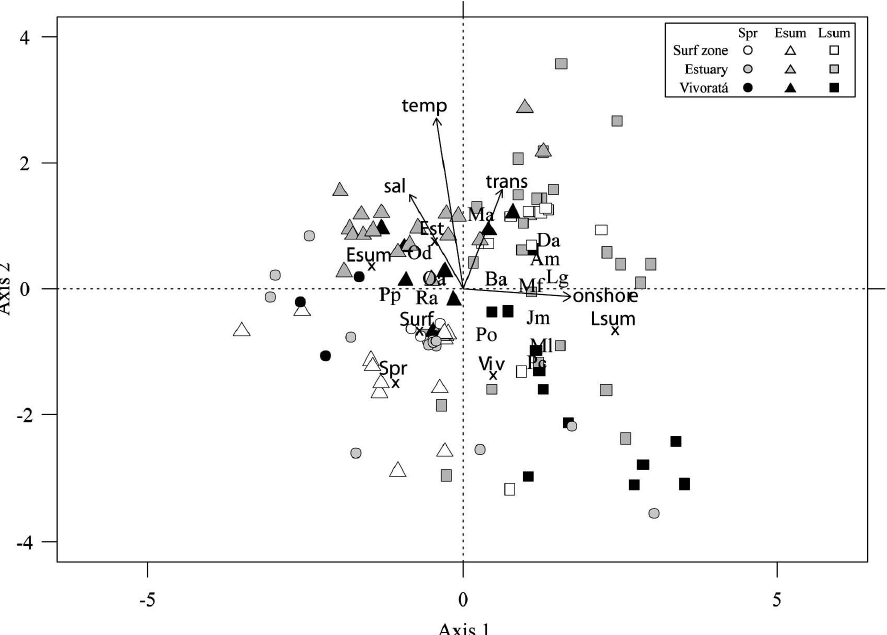
Fig. 5. – Ordination diagram (triplot) of the CCA. Temporal and spatial factors are indicated by crosses and environmental variables are indicated by arrows. Abbreviations are as follow: Spr, spring months; Esum, early summer months; Lsum, late summer-early autumn months; Surf, surf zone; Est, estuary; Viv, Vivoratá stream; temp, temperature; sal, salinity; trans, transparency; onshore, onshore winds. See Table 2 for species abbreviations. Table 5. – Results of the partial CCA and variance decomposition showing the effects of Season, Zone and “Others” explanatory variables (onshore wind, temperature, salinity and transparency). Components A, B and C are equal to the explained variances in steps 5, 6 and 7, respectively. D is equal to the variance in step 4 minus the variance in step 7, and E is calculated as total inertia minus the explained inertia in step 1. Results of the partial CCA Step